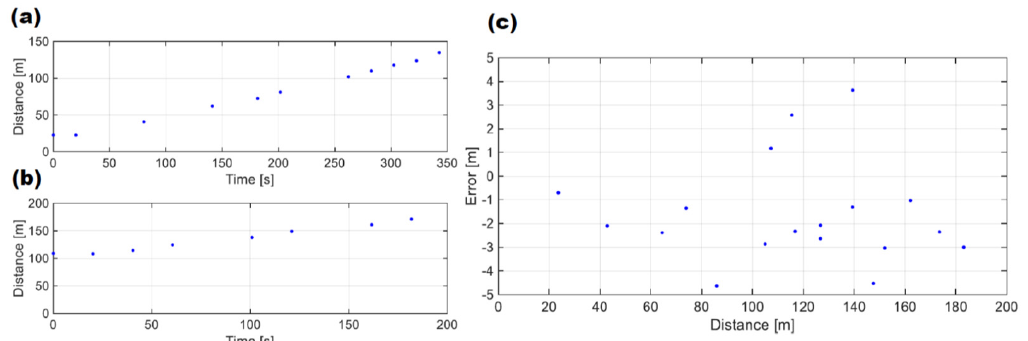
Figure 5. (a,b) Changes in the distance between two UAVs. The horizontal axis is the elapsed time, and the vertical axis is the distance recorded by the acoustic devices. The results in ( a ) and ( b ) show the distances for the first and second flights, respectively. ( c ) Difference between the distance measured by the underwater acoustic devices and the GNSS mounted on the UAV. The horizontal axis is the GNSS distance, and the vertical axis is the distance difference (acoustic sensor distance–GNSS distance).